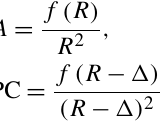
Figure 19. Aerosol backscattering coefficient (11 February 2021, 19:45–20:44UTC); comparison between the overlap-corrected (solid black line) and uncorrected (dashed red line)